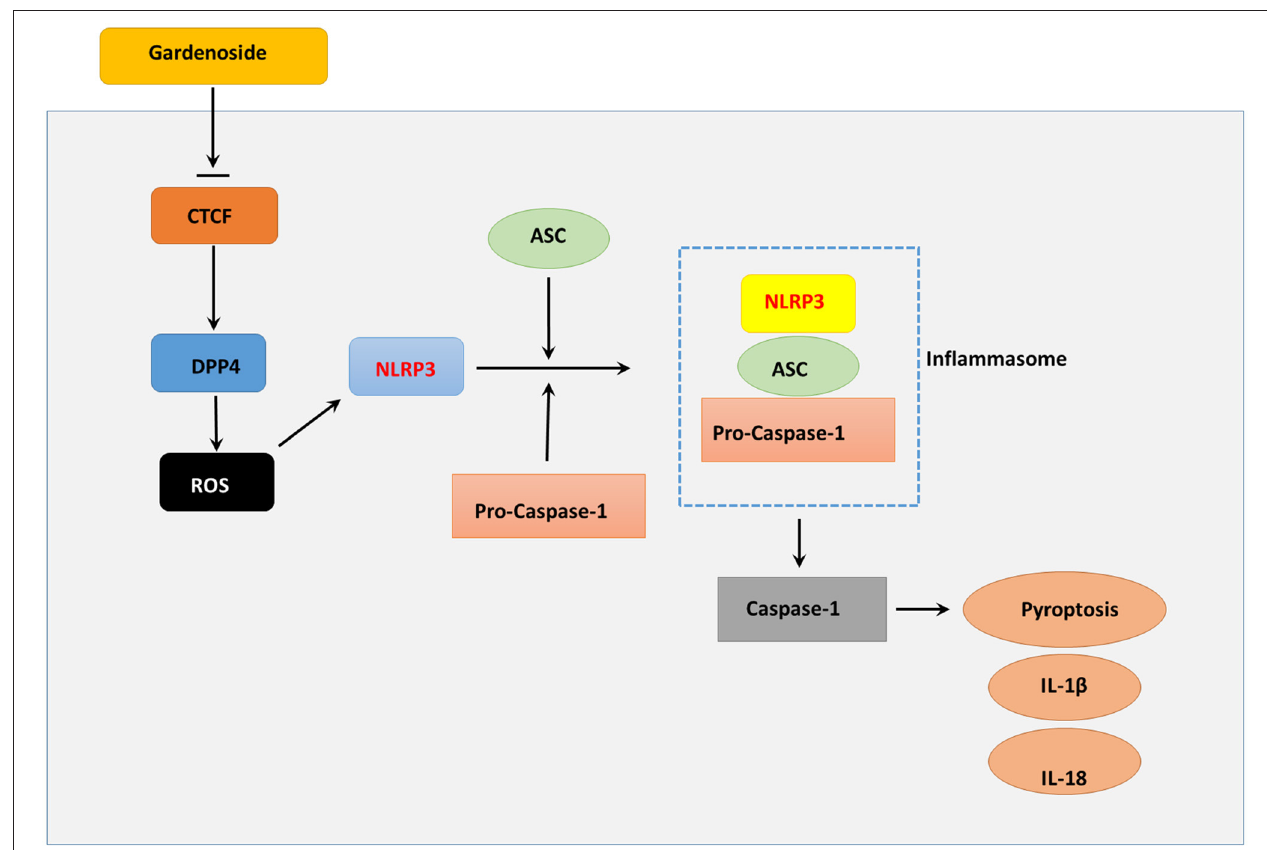
FIGURE 10 | Summary diagram showing that gardenoside inhibits the activation of NLRP3 inflammasome and caspase-1-induced pyroptosis via CTCF/DPP4 signaling